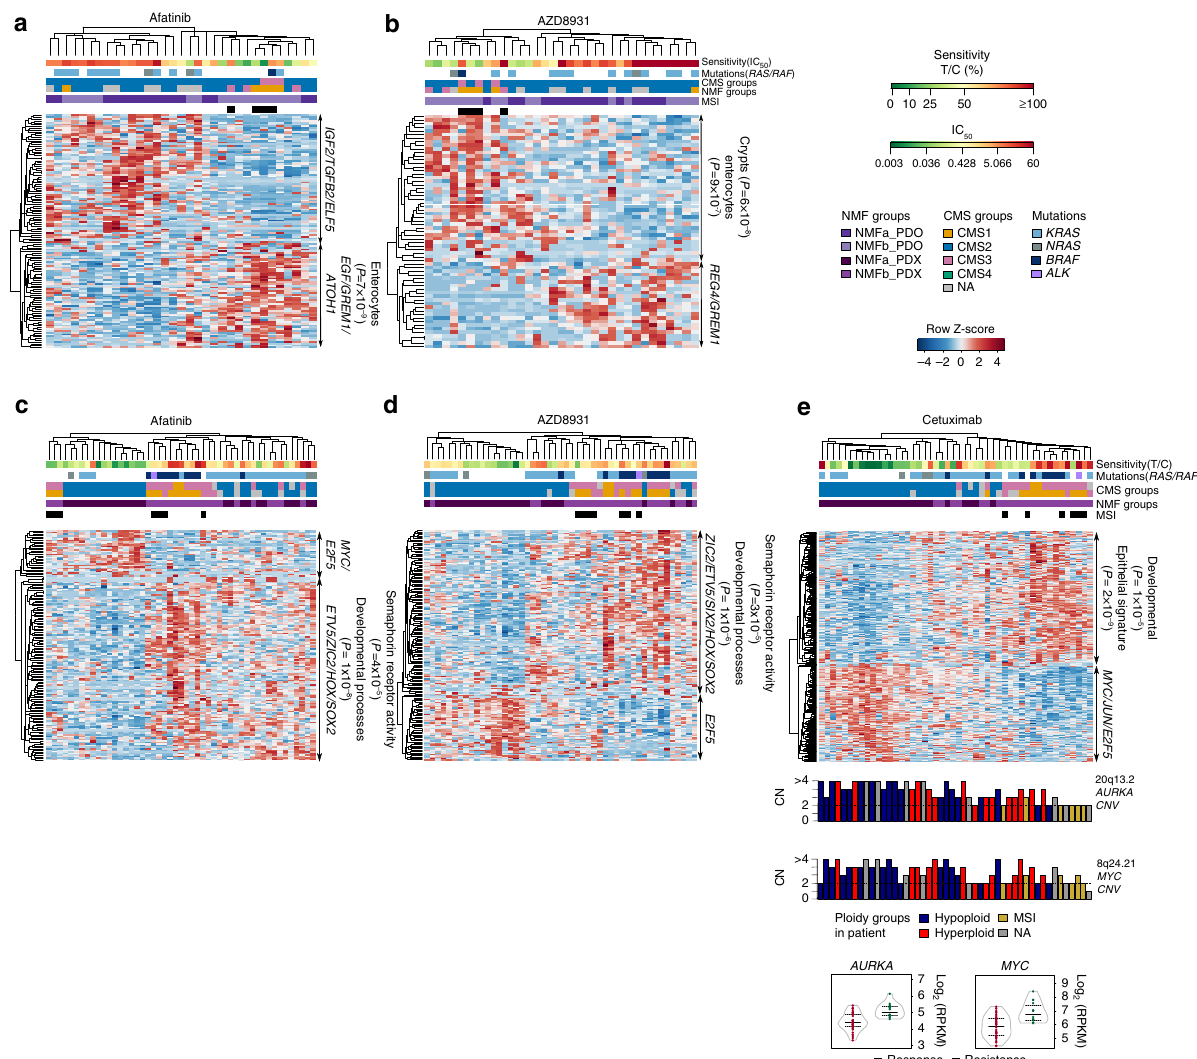
Figure 9 | Molecular classification of response to EGFR inhibitors in PDX and PDO models. Drug sensitivity is represented by T/C (PDX) or IC 50 (PDO) continuous values coloured as indicated in the caption (dark green: strong response, red: resistance). MSI samples, OT-NMF-groups and CMS classifications (SSP: upper row, RF: bottom row) and mutation status are coloured as indicated in the caption. ( a , b ) Hierarchical clustering of 33 PDO samples based on the drug response gene signatures for afatinib ( a ) or AZD8931 ( b ). ( c , d , e ) Hierarchical clustering of 49 PDX samples based on the drug response gene signatures for afatinib ( c ), AZD8931 ( d ) or cetuximab ( e ). Copy numbers (CN) of MYC (8q24.21) and AURKA (20q13.2) loci in PDX samples are shown below the cetuximab signature. The bars are colour-coded according to the CNVgroups in the patients (Hypoploid, Hyperploid and MSI). Violin plots show the AURKA and MYC expression in responders versus resistant PDXs (response T/C r 25%, resistance T/C 4 25%). The expression values are shown as log 2 RPKM. Lines indicate the 25%, 50% and 75% quantiles, respectively.